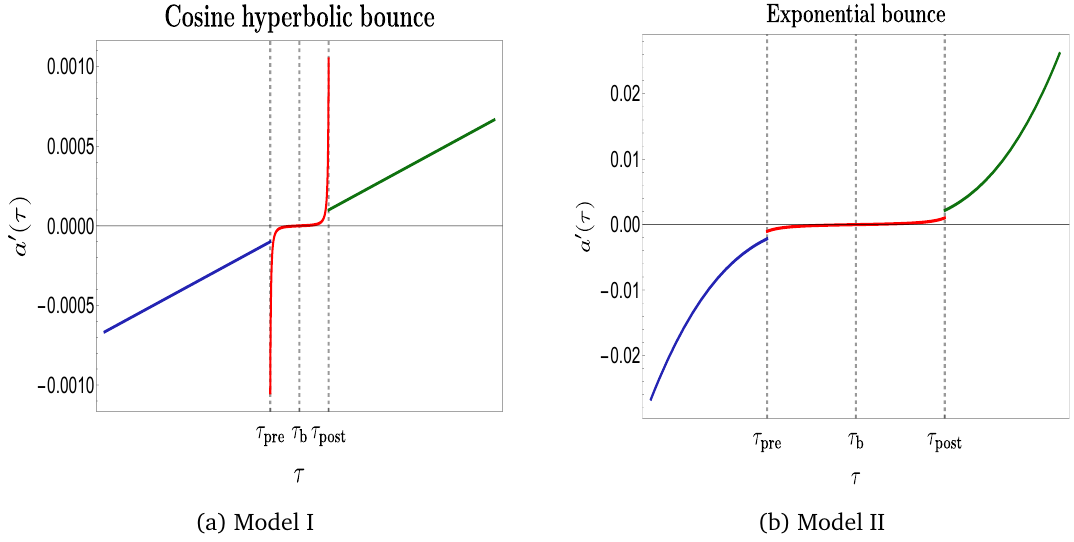
Figure 4: Variation of derivative of scale factor wrt the conformal time showing three different regions viz. Pre-bounce, Bouncing and the Post-bounce regions.